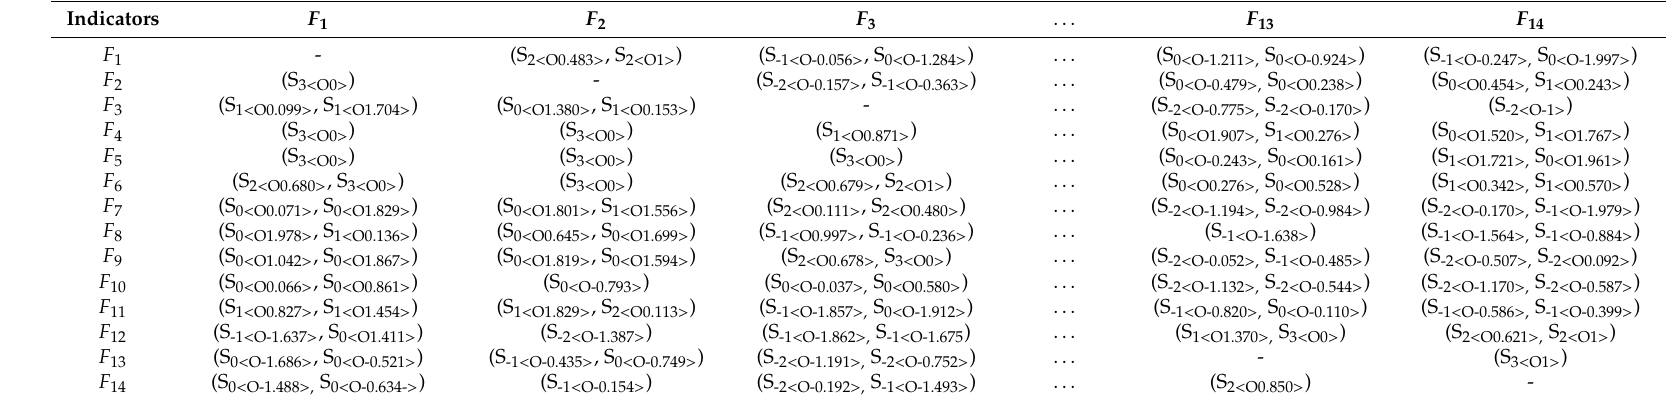
Table 3. The group hesitant linguistic evaluation